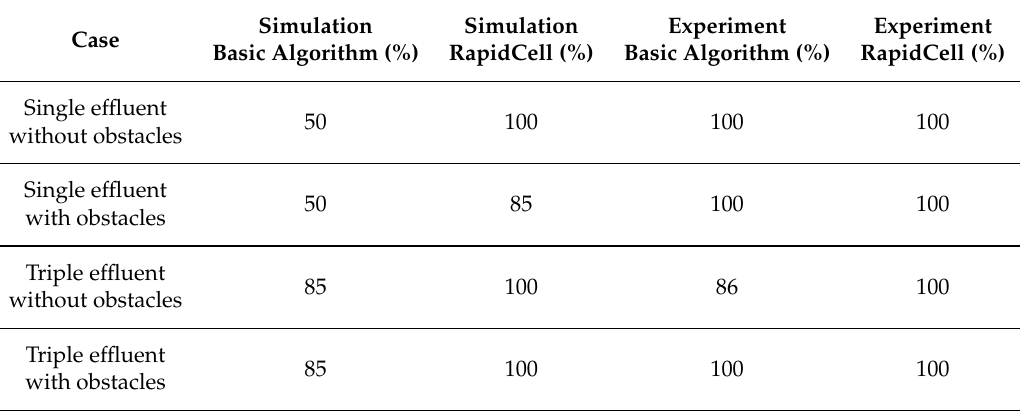
Table 2. Success rate